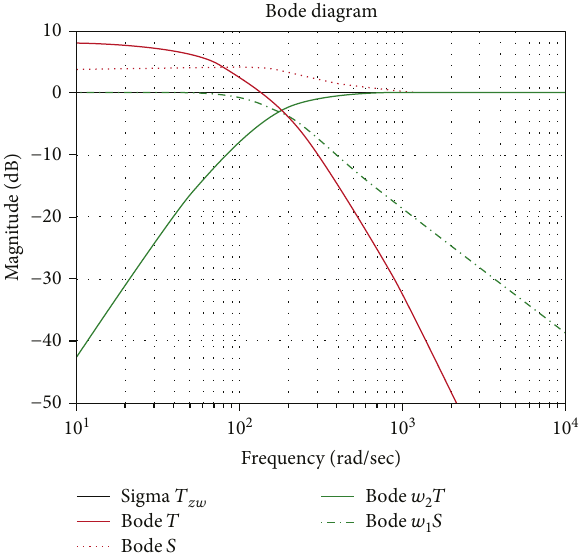
Figure 13: Singular value characteristic of the system.